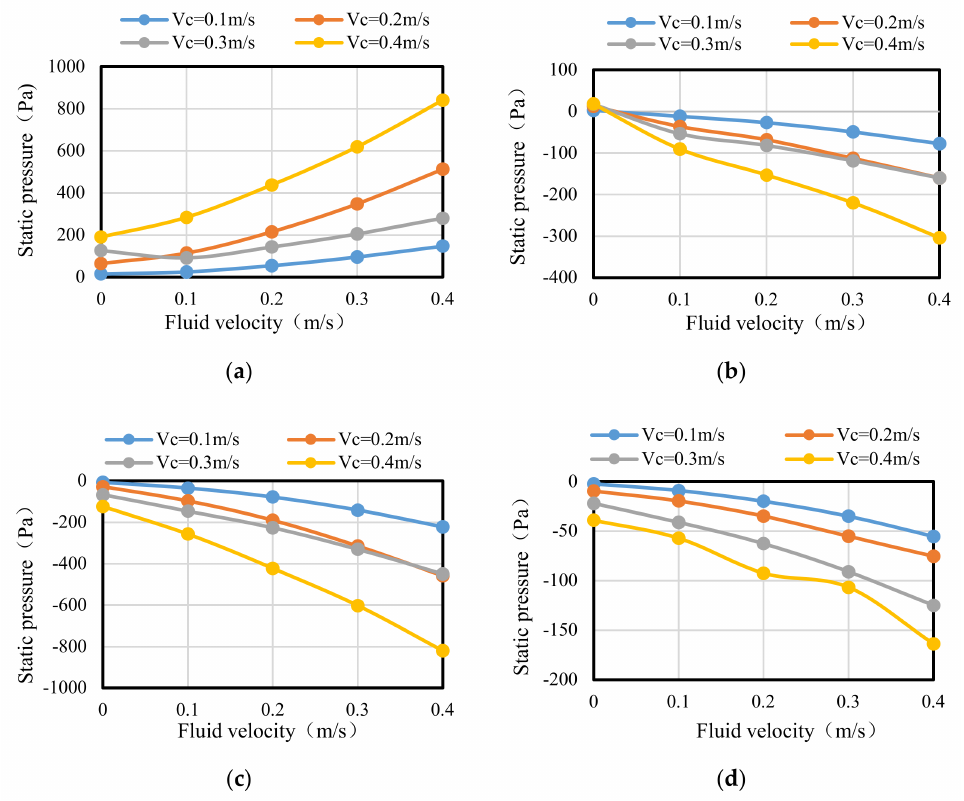
Figure 7. Static pressure curves at key points. ( a ) Sensor 1; ( b ) Sensor 6; ( c ) Sensor 10; ( d ) Sensor